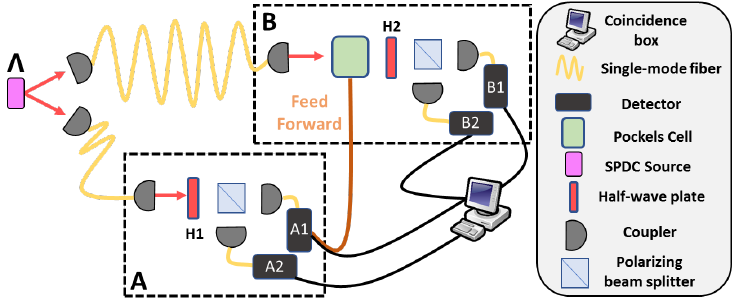
Figure 2. Experimental Apparatus. We generate a singlet state through a SPDC process (constituting our hidden variable Λ ) that is shared by the two parties A and B. On A’s path, the measurement station is made by a HWP followed by a PBS, since the qubits are encoded in the polarization of the photons. On B’s path, there is an analogous measurement station, but, before the HWP H 2 , we put a Pockels cell, to switch from one operator to the other, in the case of active feed-forward, i.e., triggering a high voltage application to the Pockels cell and making it behave as a HWP, while, when it is not triggered, it performs the identity. The voltage application is triggered by Alice’s detector A 1 (i.e., corresponding to output 0), whose signal is split and sent both to a coincidence counter and to the Pockels cell. In the post-selection case, the Pockels cell is not triggered and A and B choose independently the measurement basis, performing the desired observables rotating respectively H 1 and H 2